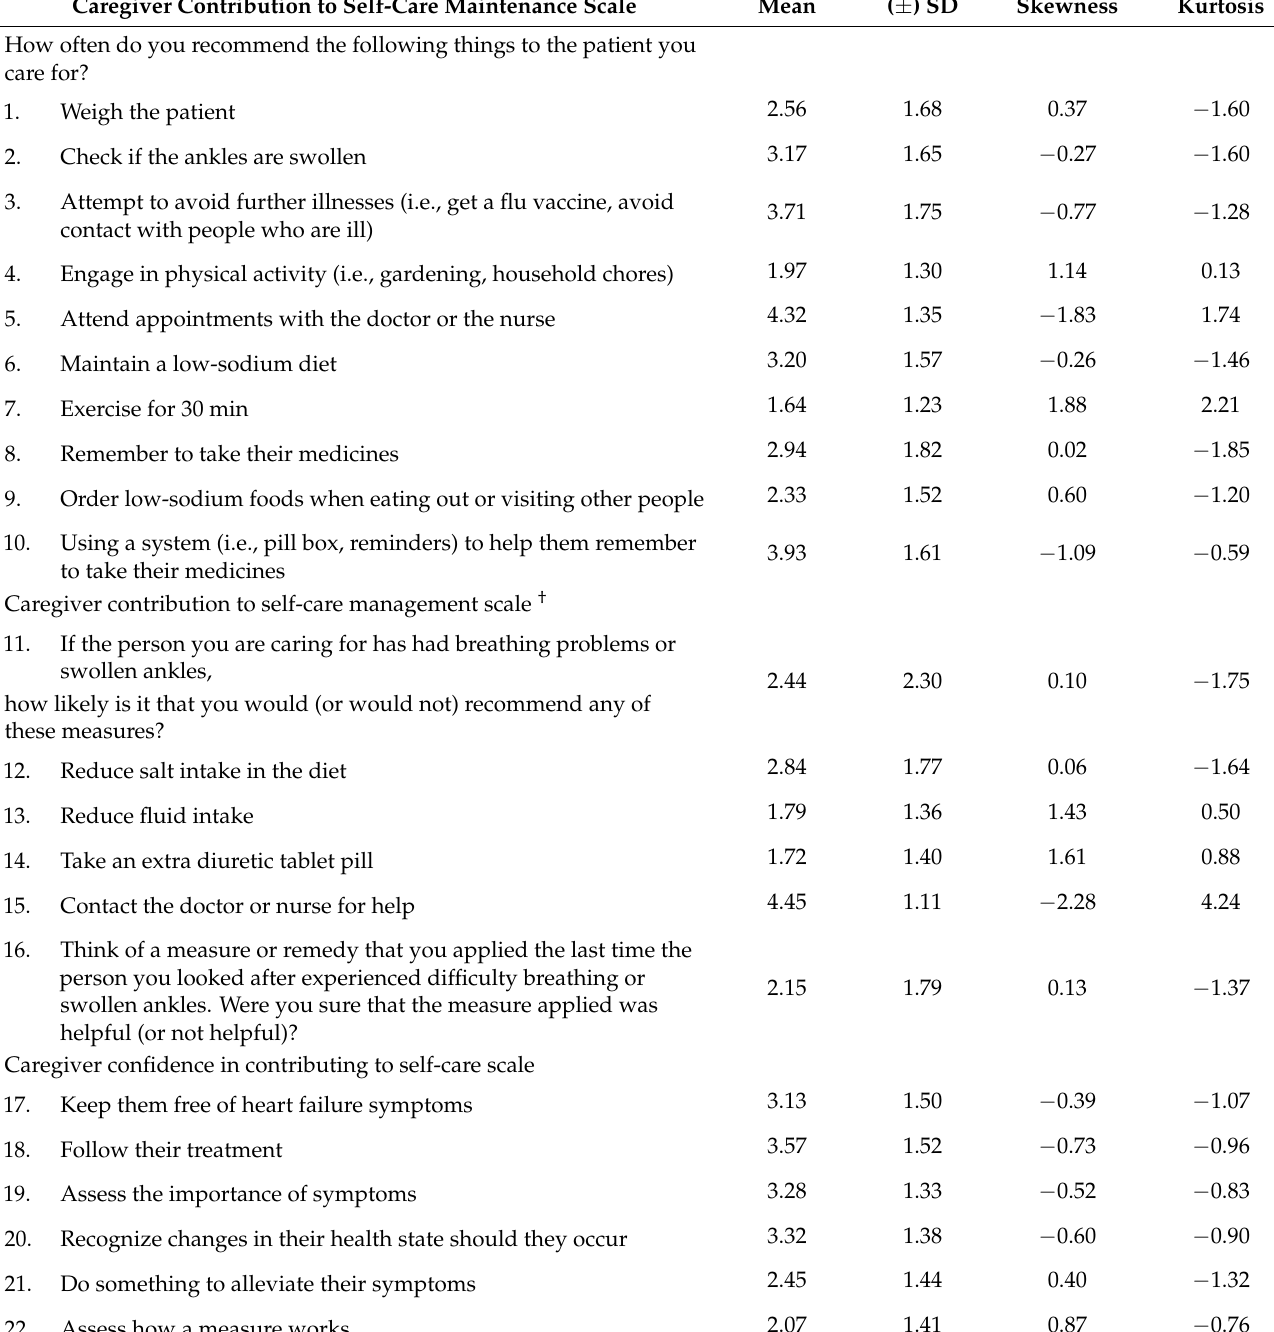
Table 2. Descriptive statistics of the Caregiver Contribution to Self-Care of Heart Failure Index (CC-SCHFI v.1)